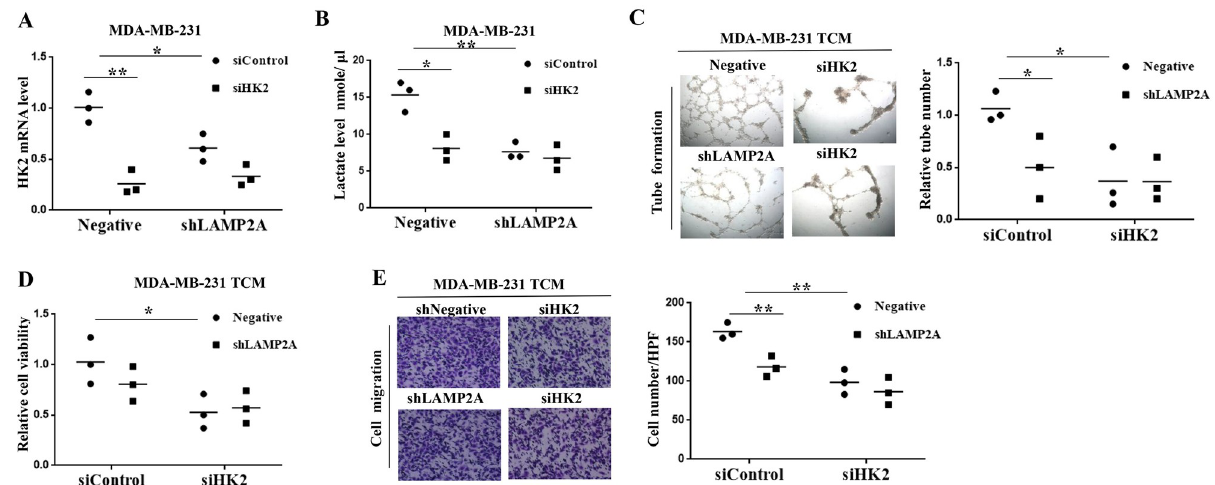
Fig 7. HK2 knockdown in breast cancer cells inhibited angiogenesis of HUVECs. (A) HK2 mRNA expression level was detected by real-time PCR in MDA-MB-231 cells after HK2 siRNA transfection. (B) Lactate level was detected in TCM from MDA-MB-231 cells after HK2 siRNA transfection. (C) TCM was collected from MDA-MB-231 cells after HK2 siRNA transfection, cocultured with HUVECs for 12 h, and then tubule numbers were counted via tube formation assay. (D) TCM collected from MDA-MB-231 cells after transfected with HK2 siRNA were cocultured with HUVECs for 48 h, and then cell viability of HUVECs was detected by MTT assay. (E) Cell migration of HUVECs was detected by Transwell migration assay after HK2 knockdown in MDA-MB-231 cells. All values are representative of three different experiments; � P < 0.05, �� P < 0.01.